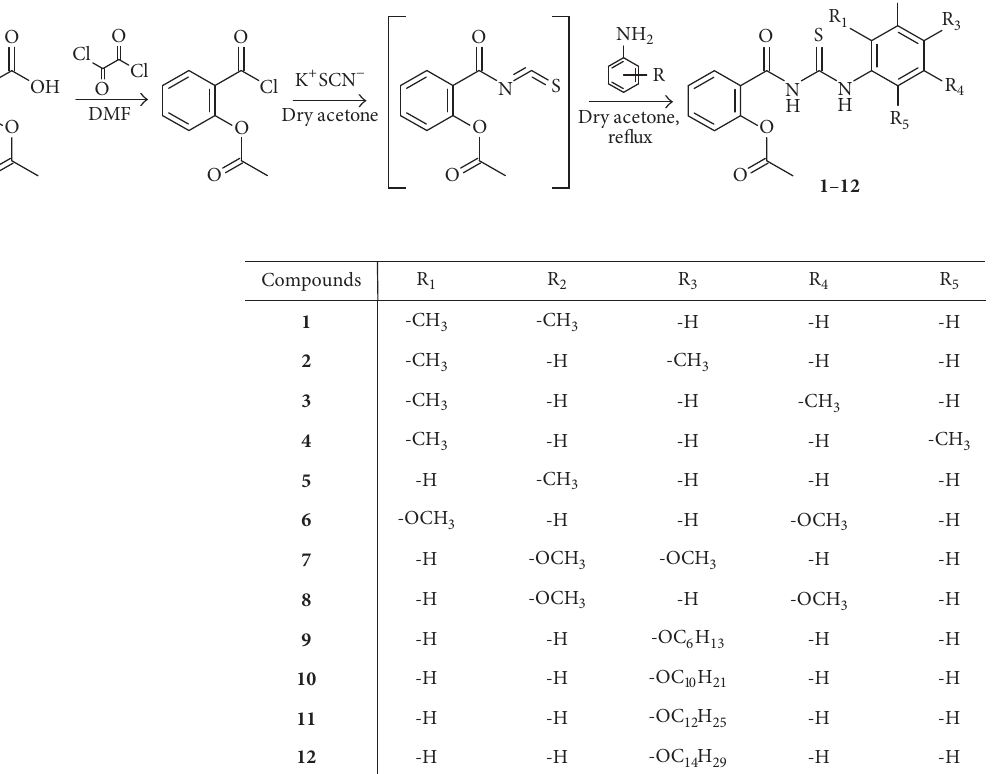
Scheme 1: Synthesis of aspirin derivatives 1 – 12